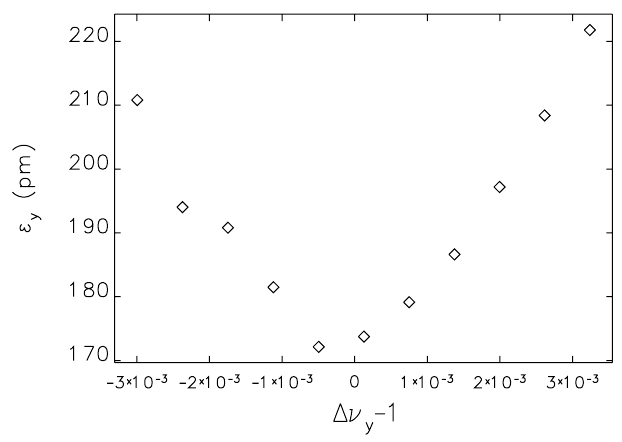
FIG. 16. Eventual vertical emittance as a function of betatron phase advance between the two crab cavities, for h (cid:3) 8 and V (cid:3) 4 MV .